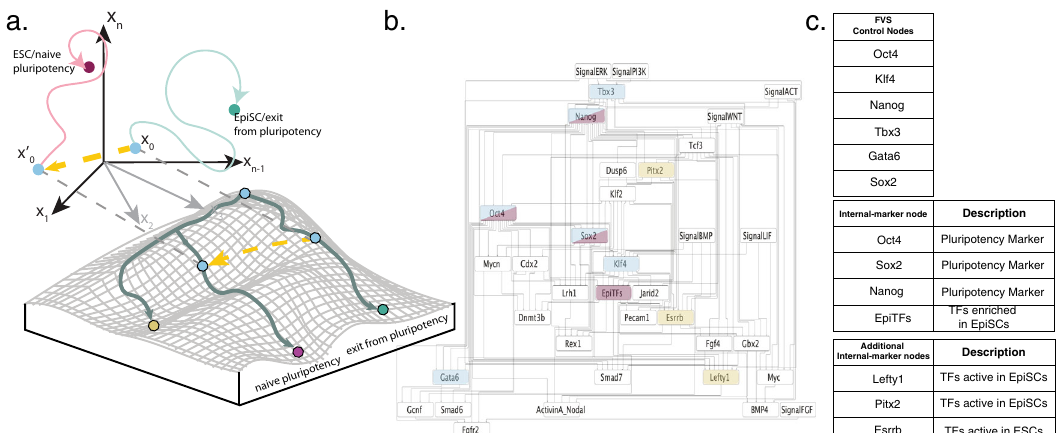
Fig. 5 Reprogramming of epiblast stem cells (EpiSCs) to embryonic stem cells (ESCs). a The goal of this study is for NETISCE to identify the perturbations on FVS control nodes that shift EpiSCs toward ESCs, reverting from a primed to a naive pluripotent state. To that end, we initialize the system with the gene expression data from EpiSC cells ( x 0 ), and, with the correct combination of perturbations on FVS control nodes, shift the system to a state (yellow arrow leading to x ′ 0 ) that leads to the ESC cell fate (magenta circle). b Pluripotent stem cell signaling network as constructed by Yachie-Kinoshita et al. 57 . The network contains 36 nodes and 143 edges. Nodes colored in blue are FVS control nodes, nodes with magenta coloring are the internal-marker nodes used by Yachie-Kinoshita et al., and gold nodes are the additional internal- marker nodes we used for further selection of perturbations on FVS control nodes. Note that the nodes Sox2, Nanog, and Oct4 are FVS control nodes and internal-marker nodes, and thus colored with both blue and magenta. c Key nodes for the desired cell fate reprogramming. There are six FVS control nodes within the system. Four internal-marker nodes were used by Yachie-Kinoshita et al. to identify successful reprogramming targets for the ESC state. We identi fi ed an additional three internal-marker nodes to fi lter perturbations on FVS control nodes. In the second column for the internal-marker nodes, we denote which behavior they represent in pluripotency